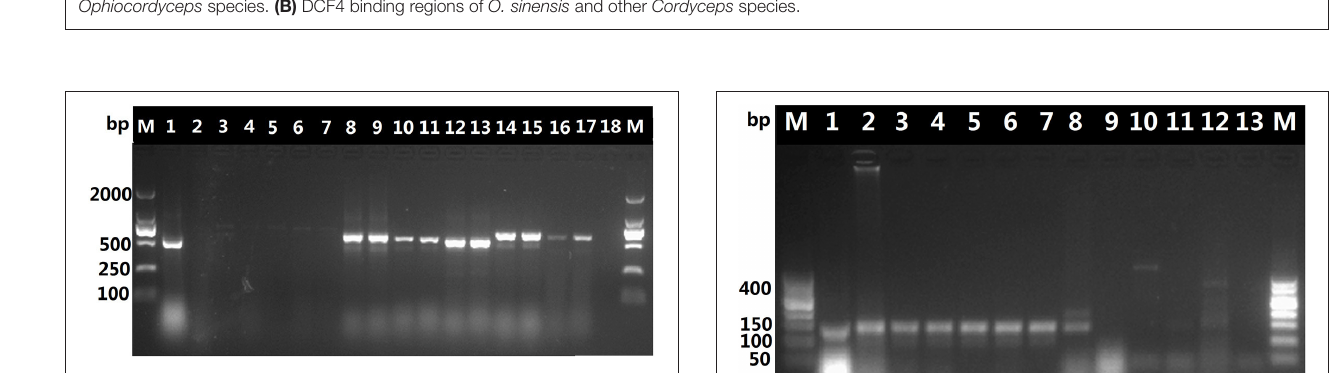
FIGURE 2 | Amplification products generated with ITS universal primer pair 5F/4R and DNA from decoction and adulterants. Lane 1, pure O. sinensis DNA ( ∼ 120 ng); lanes 2, 3, and 4, products from amplification of DNA ( ∼ 30 ng) isolated from decoction boiled for 60 min; lanes 5, 6, and 7, amplification products from DNA ( ∼ 30 ng) isolated from decoction boiled for 90 min; results for amplification with pure DNA ( ∼ 30 ng) from C. liangshanensis (lanes 8–9), C . militaris (lanes 10-11), O . nutans (lanes 12–13), C . gunnii (lanes 14–15) and C . cicadae (lanes 16–17).